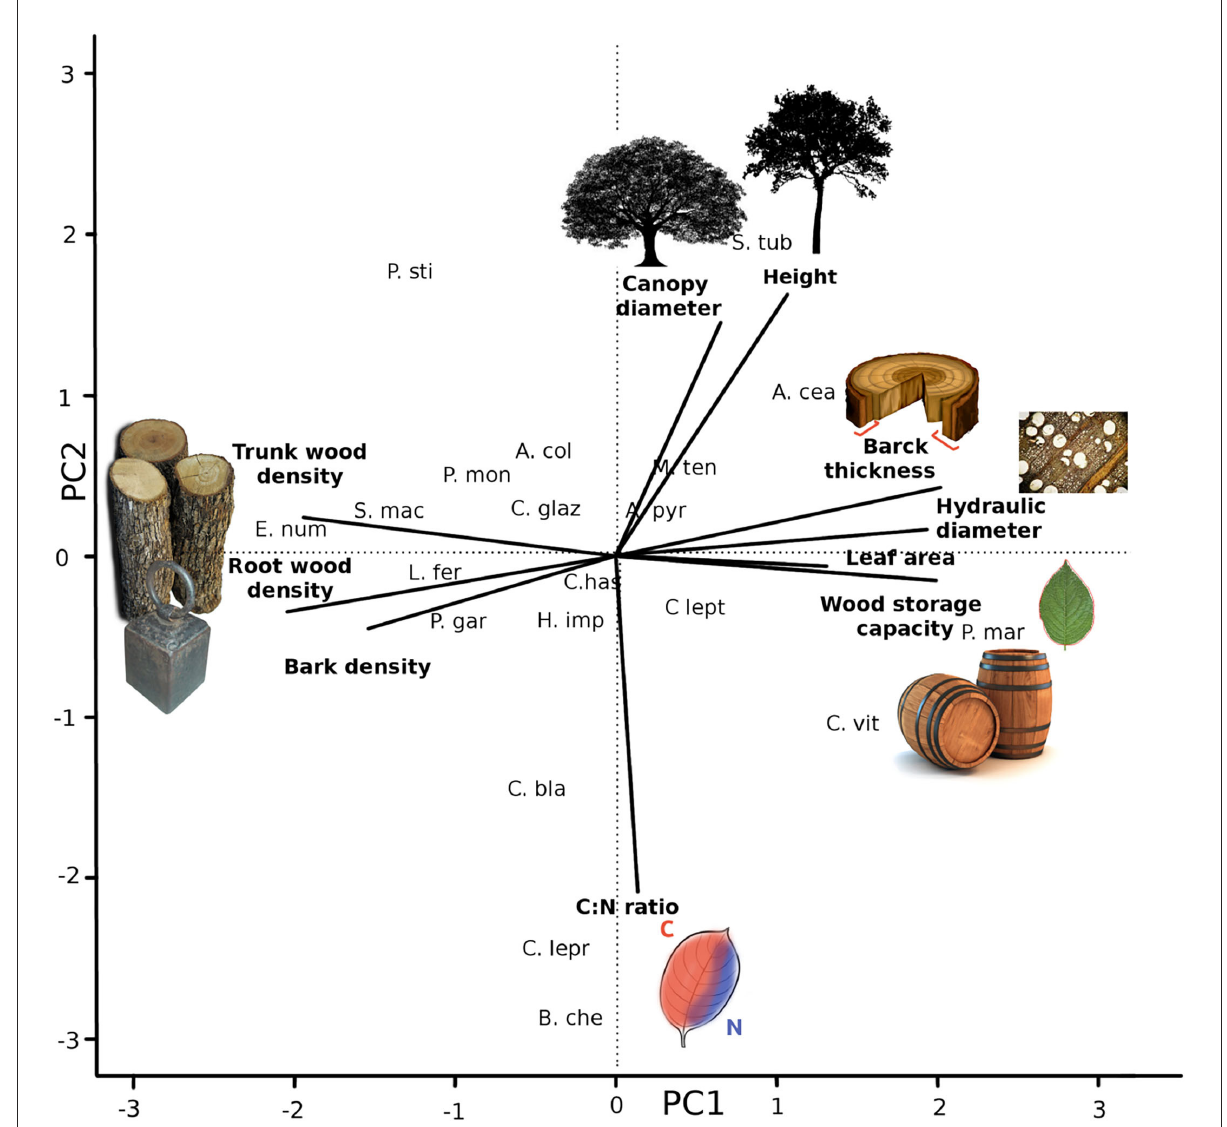
FIGURE1 Coordinated trade-offs based on PCA analysis. Results of the two first axis of a PCA analysis with selected trait scores higher than 0.5. On PC1 Leaf area, Wood density, Wood storage capacity, Bark density, Bark thickness, hydraulic weighted diameter capacity, and Root density. PC2 is represented by Canopy diameter and Leaf C:N ratio. The analysis was performed with 20 tree species of Caatinga SDTF. The full name of the species can be found in Table